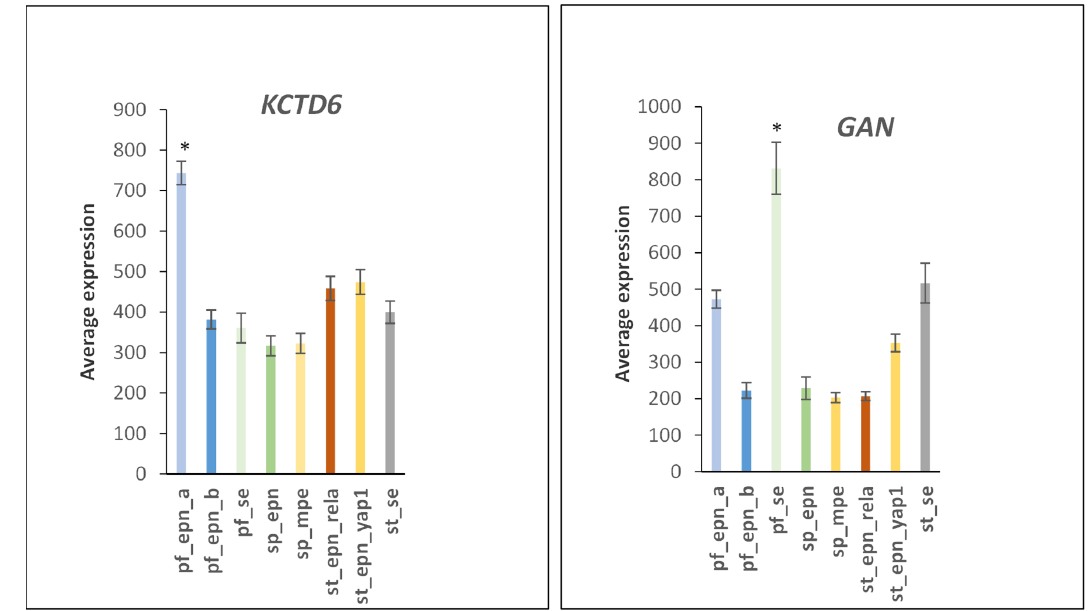
Figure 19. Elevated gene expression of KCTD6 (pf_epn-a) and GAN (pf-se) (by Anova F = 21.73, p = 1.023–21 and F = 33.29, p = 1.71 × 10 − 30). * by t -test significantly different from other groups p < 0.001, − 30 ). * by t -test significantly different from other groups for KCTD6 and p < 0.01 for GAN. Dataset GSE64415. p = 1.023–21 and F = 33.29, p = 1.71 × 10 p < 0.001, for KCTD6 and p < 0.01 for GAN. Dataset